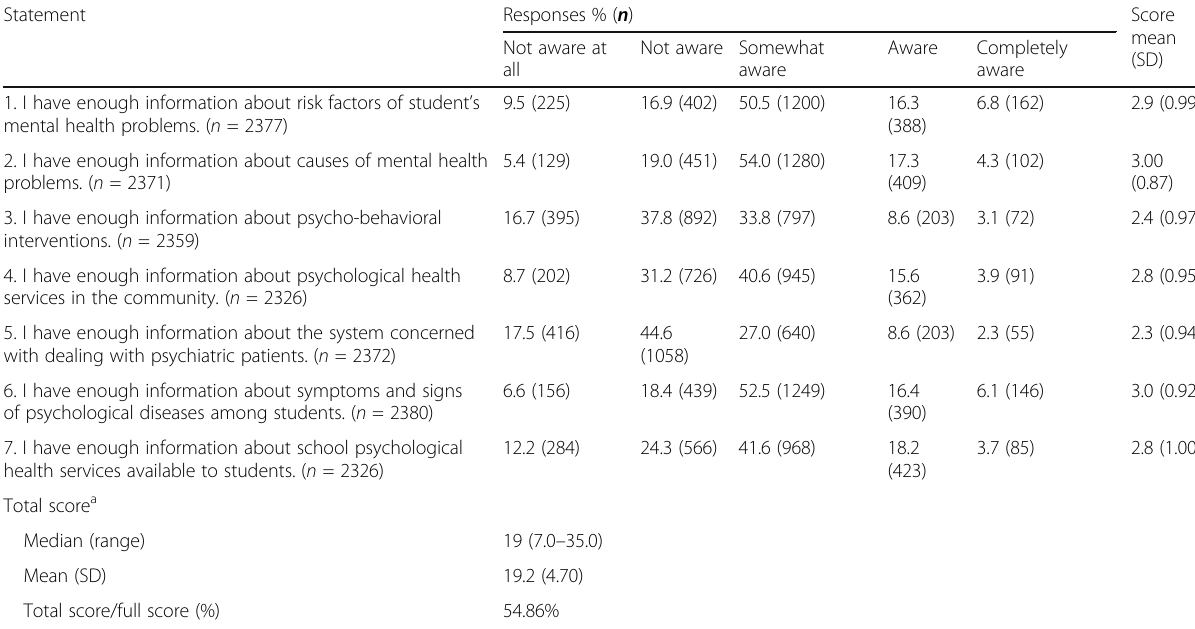
Table 2 Teachers ’ awareness about students ’ mental health